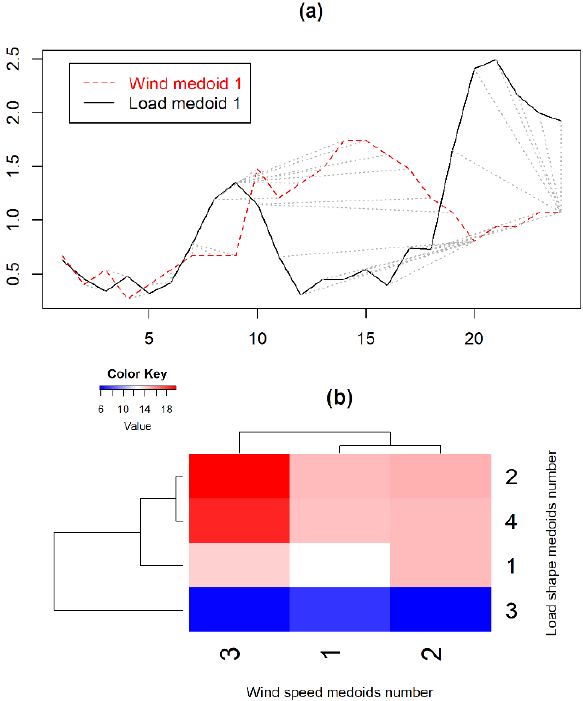
Figure 11. Computation of distance matrix between load and wind speed medoids using DTW dissimilarity. ( a ) Illustration of computation of DTW distance for one combination load-wind speed medoids. ( b ) Distance matrix in heatmap format.